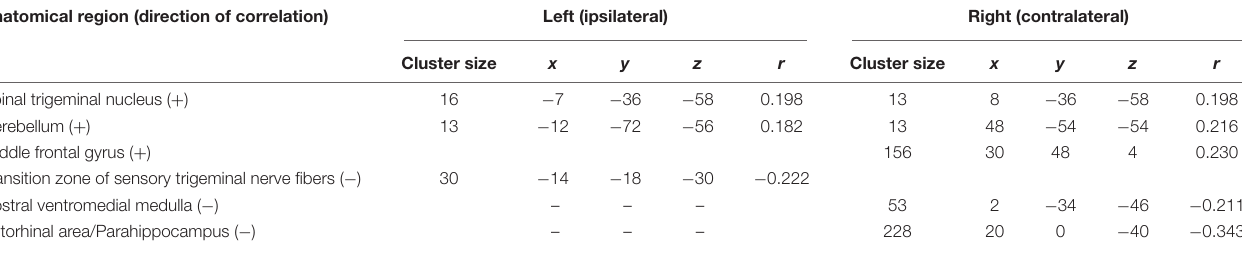
TABLE 2 | Trial-to-trial correlations between EEG and fMRI for the trigeminal nociception for the theta/delta frequency band at electrode Pz using a statistical threshold of p < 0.005 (uncorrected). Anatomical region (direction of correlation) Left (ipsilateral) Right (contralateral) Cluster